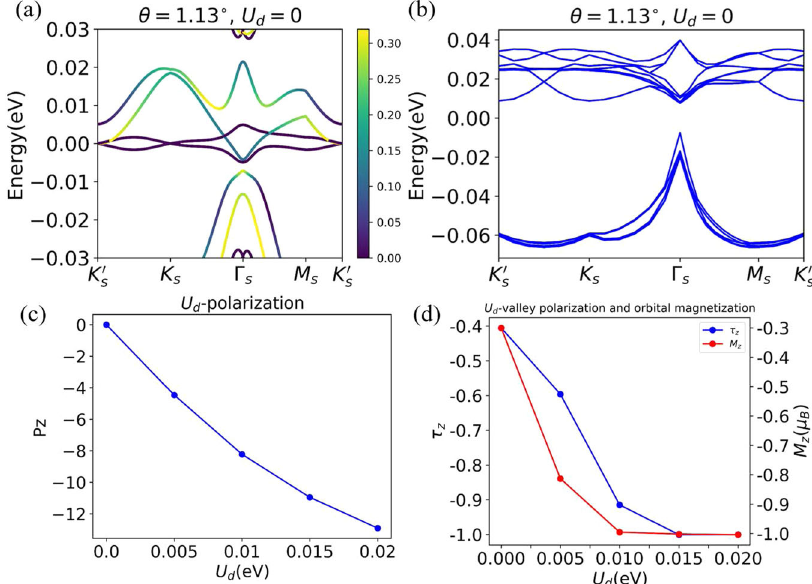
Fig. 2 Band structures and orbital magnetoelectric effect in A - ABA - A system. The band structure of A - ABA - A for two valleys including intrasublattice moiré potential and the further neighbor interlayer hopping. a The non-interacting band structures with weight projected to the middlemost layer. b The Hartree – Fock band structure for two valleys. c The vertical polarization, and d the valley polarization and the corresponding orbital magnetization of the symmetry-breaking ground state at -3 fi lling as a function of vertical electrostatic potential drop U d .